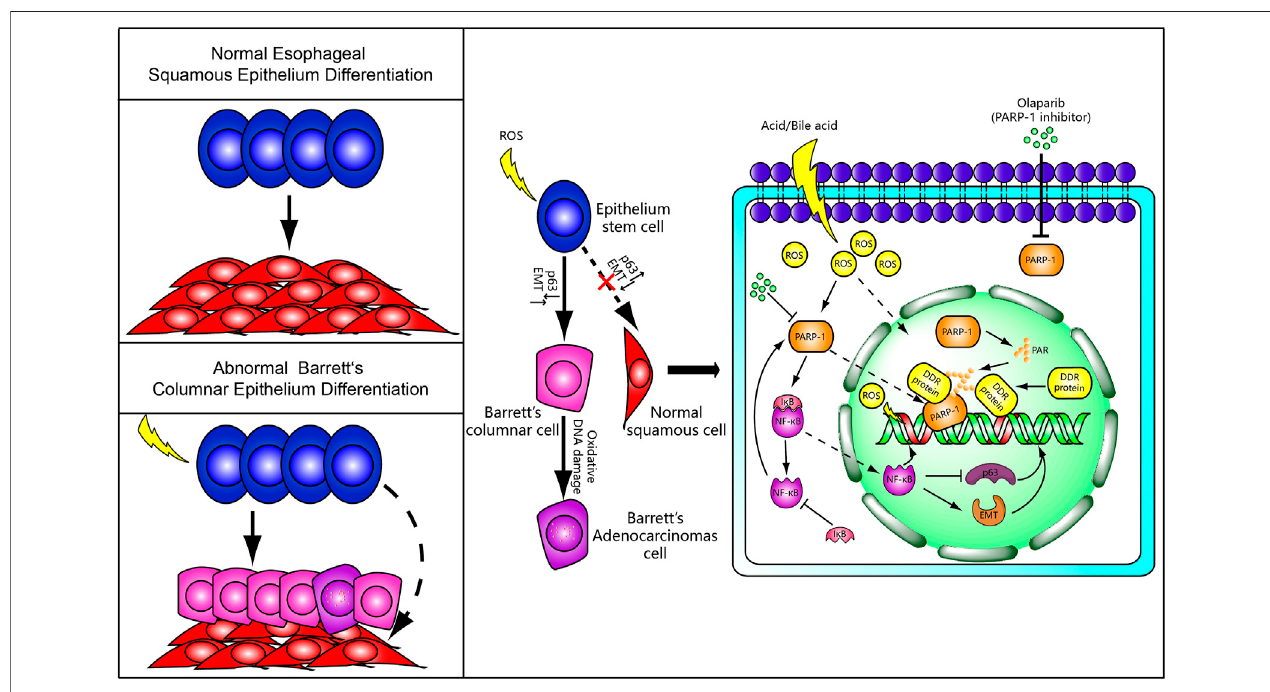
FIGURE 1 | A putative mechanism for Barrett ’ s metaplasia and adenocarcinoma. Normally, epithelial stem cells differentiate into squamous epithelium cells. However, Barrett ’ s columnar epithelium cells and adenocarcinoma cells replace the normal squamous cells by abnormal differentiation under chronic re fl ux-induced oxidative damage and in fl ammation. We speculate that PARP-1/NF- κ B signaling and ADP-ribosylation-dependent DNA damage response may be involved in the occurrence ofBE and incompleteDNA repair possibly lead toBarrett ’ sadenocarcinoma. ThePARP-1inhibitor may serve asamolecularrescuer for